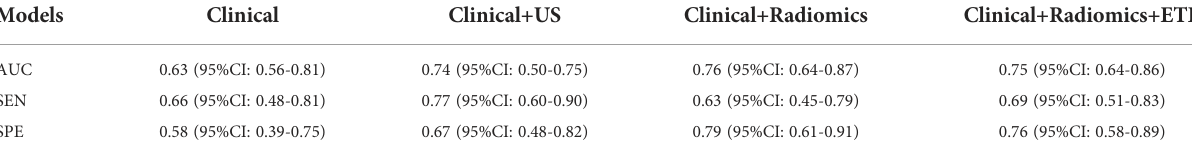
TABLE 3 The performance of different models to predict central LN metastasis of PTC based on clinical, ultrasound and radiomics feasure.